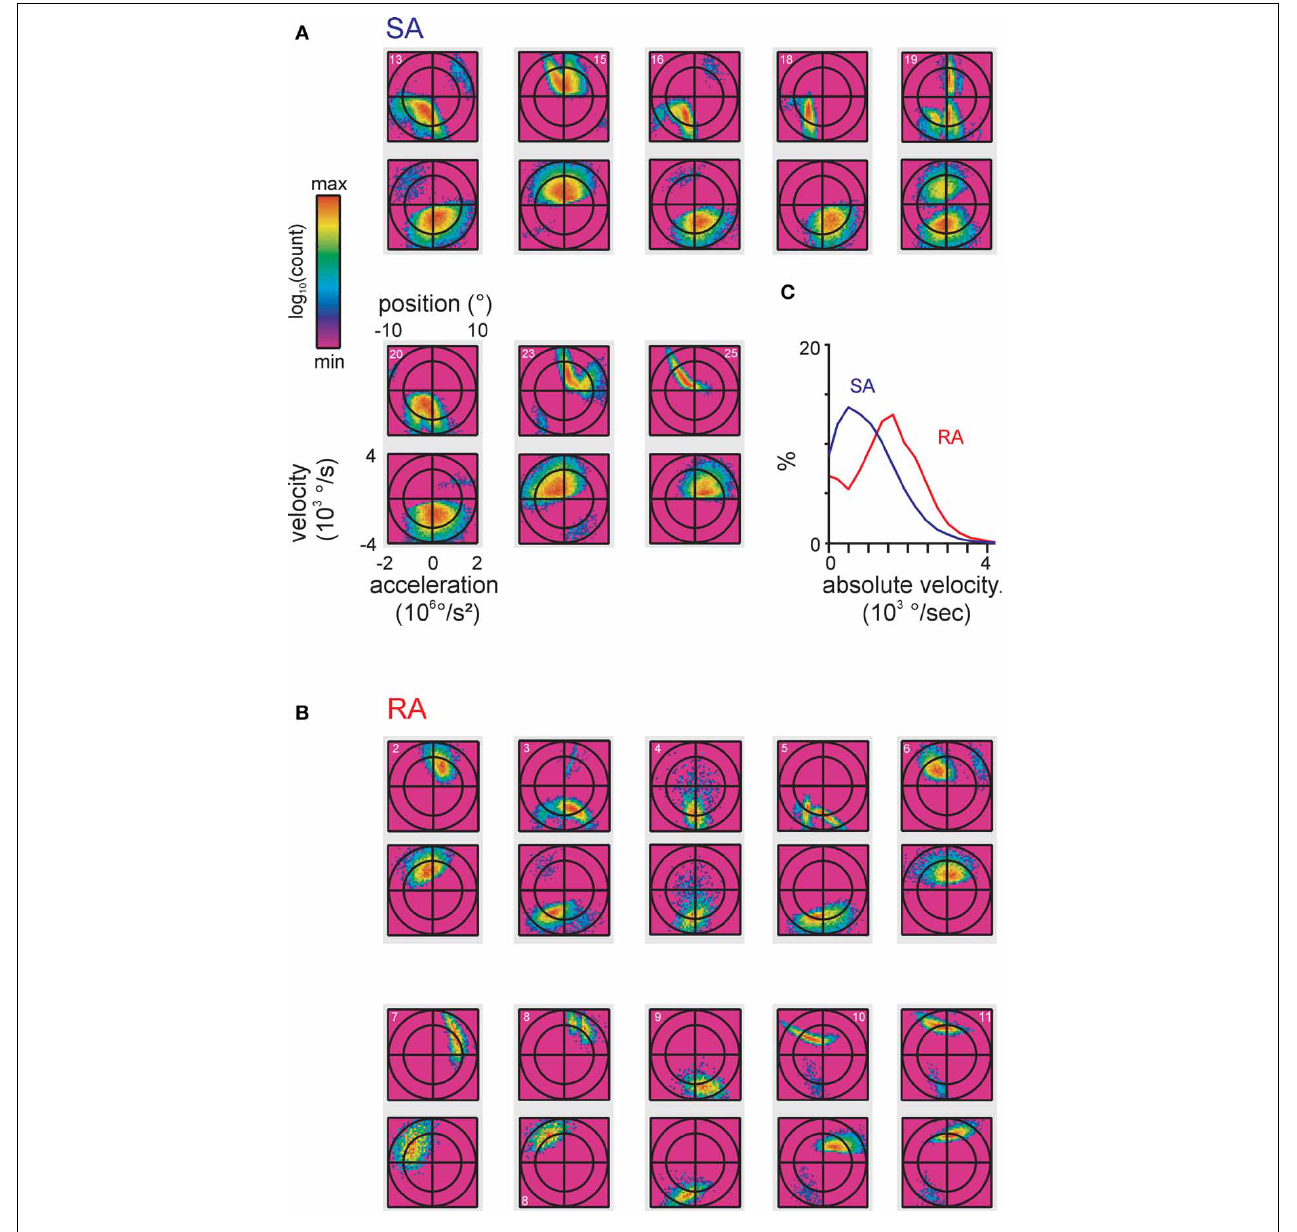
FIGURE 4 | Encoded instantaneous stimulus features for our total sample of primary afferents. (A,B) original 3D stimulus space (as done in Figure 3 ). The spike-triggered stimulus ensembles found by maximizing the Kullback-Leibler Divergence (KLD) between stimulus distribution and spike-triggered stimulus ensemble are shown. Axis scaling and labeling is identical on all plots and is only shown once for clarity. The data pertaining to